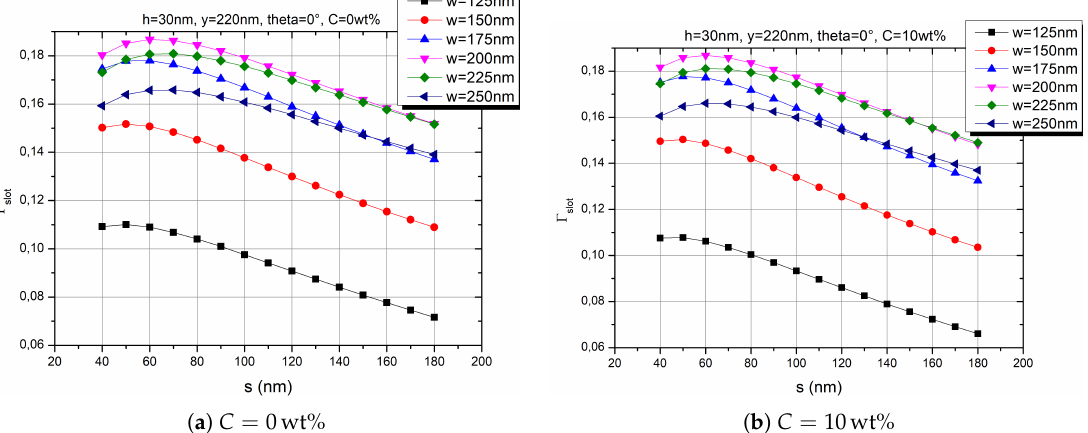
Figure A4. Field confinement factor Γ slot for both concentrations as a function of s and with w as parameter.